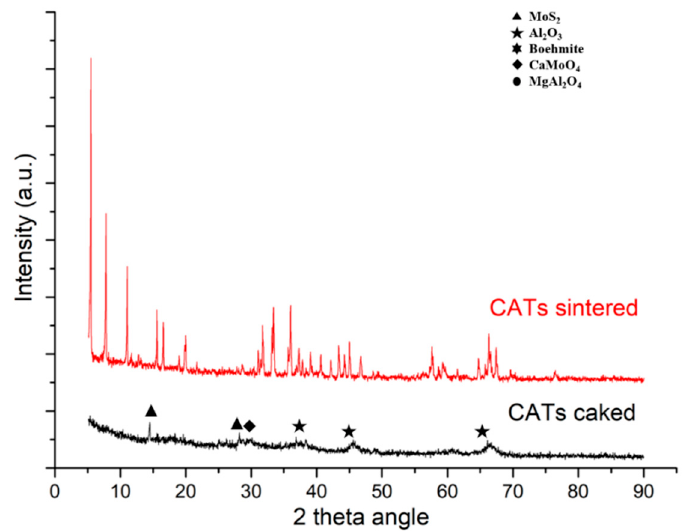
Figure 9. XRD patterns of CATs deactivated by sintering vs. by caking 2.